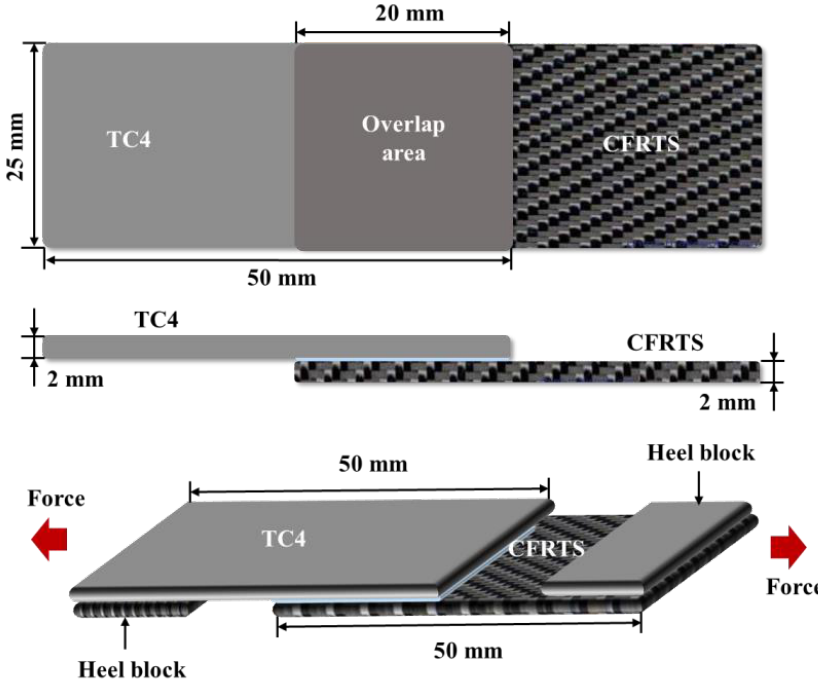
Figure 3. CFRTS-TC4 tensile sample.